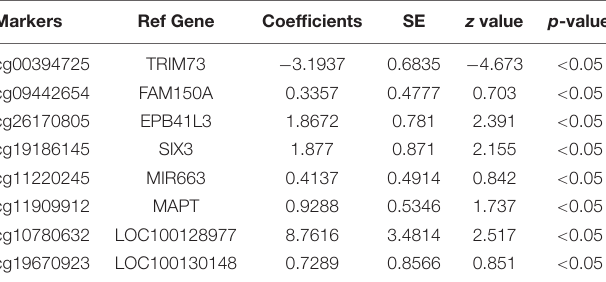
TABLE 3 | Characteristics of the eight methylation markers and their coefficients in PAAD diagnosis prediction.